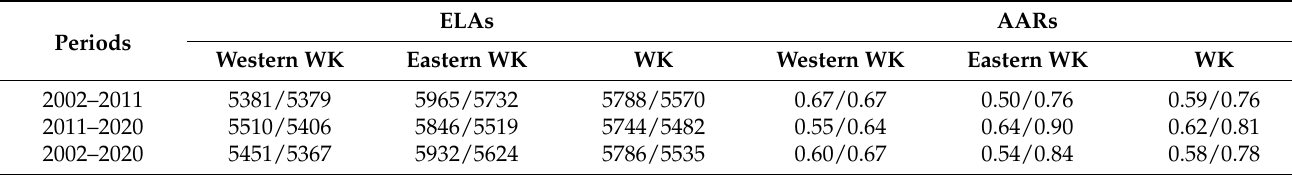
Table 5. Median and area-weighted mean ELAs (unit: m a.s.l.) and AARs in WK and its two subregions, during 2002–2011, 2011–2020, and 2002–2020 (the former are area-weighted mean ELAs or AARs, and the latter are median ELAs or AARs).